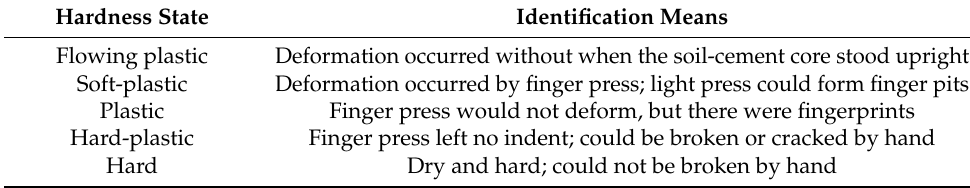
Figure 2. Drilled core of soil-cement. Table 3. Hardness description of soil-cement core.